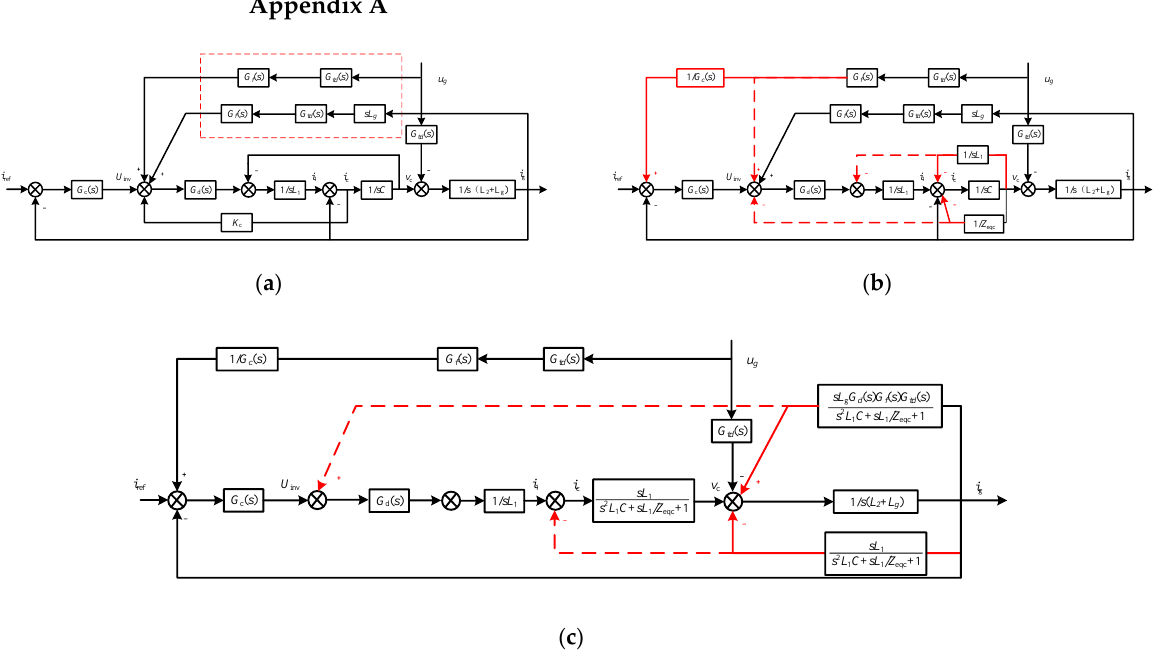
Figure A1. Detailed simplified process of mathematical model. ( a ) Simplify process I; ( b ) Simplify process П; ( c ) Simplify process Ш.